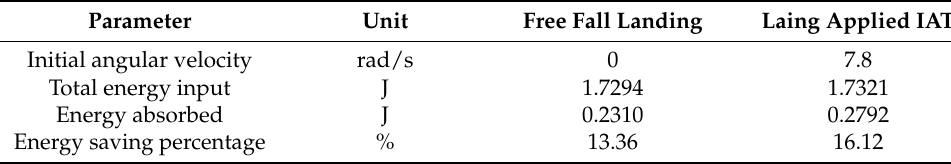
Table 5. Landing energy absorption